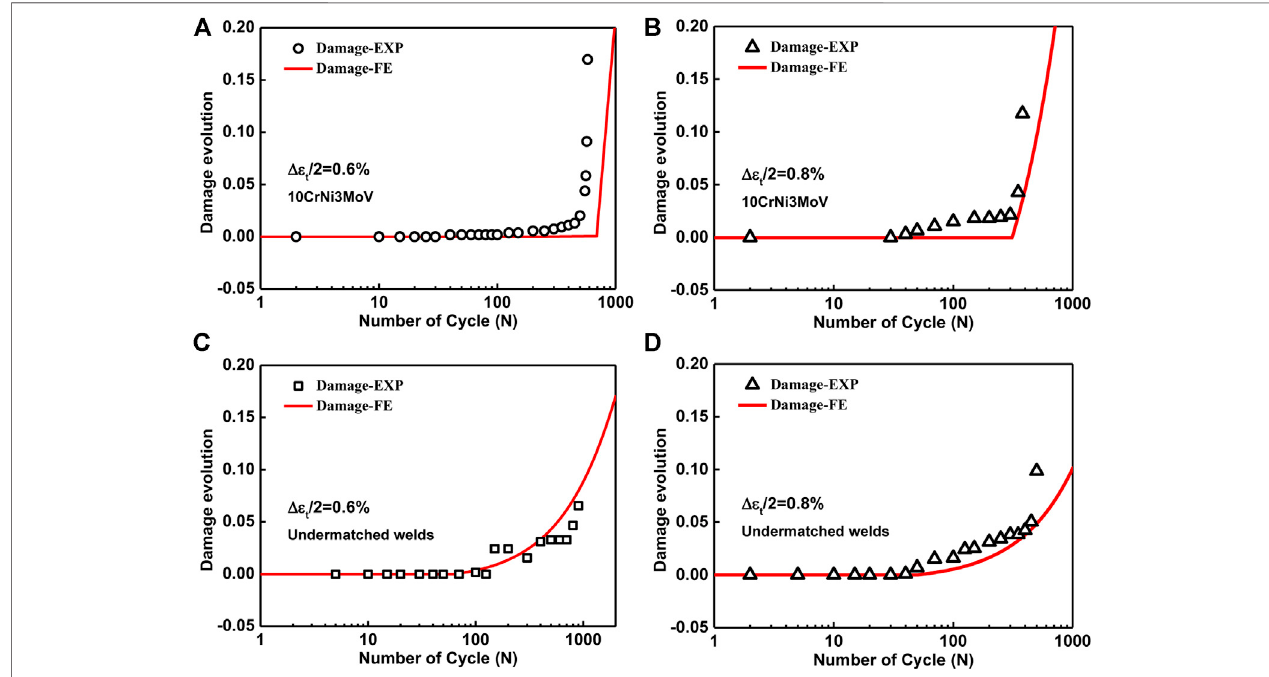
FIGURE14| Damage evolutionforbasemetaland undermatched welds. (A) Δ ε t /2 (cid:1) 0.6%for10CrNi3MoVsteel, (B) Δ ε t /2 (cid:1) 0.8%for10CrNi3MoVsteel, (C) Δ ε t /2 (cid:1) 0.6% for undermatched welds, and (D) Δ ε (cid:1) 0.8% for undermatched welds. t /2